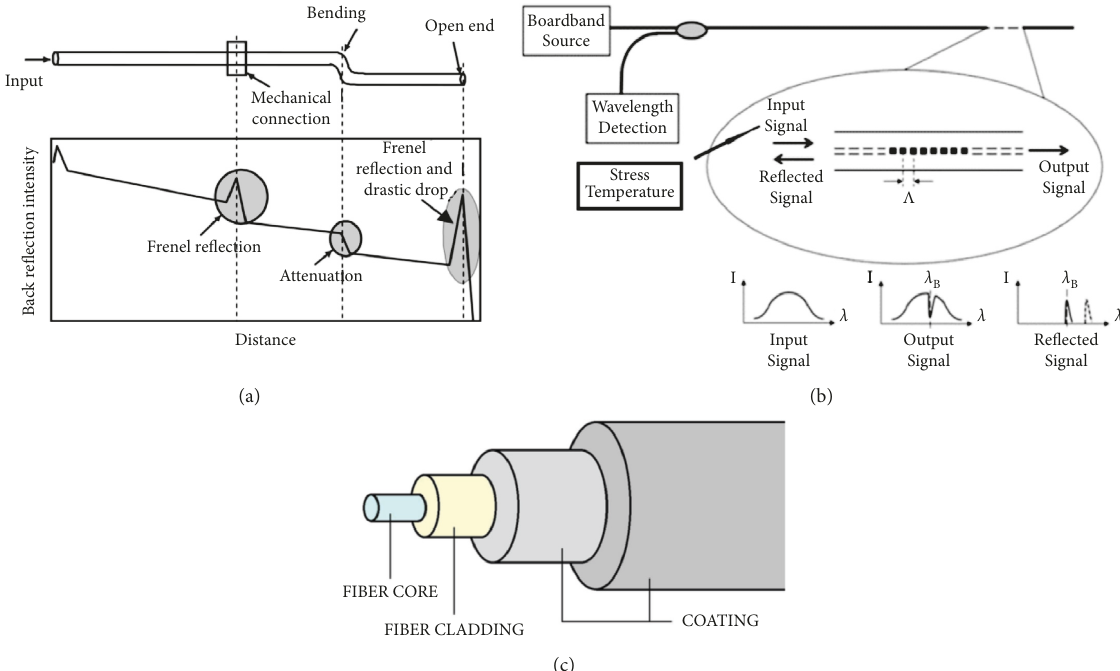
Figure 11: (a) Typical reflection chart of OTDR [71]. (b) Physical principle of stress detection of smart OFRC [72]. (c) Schematic diagram of optical fiber